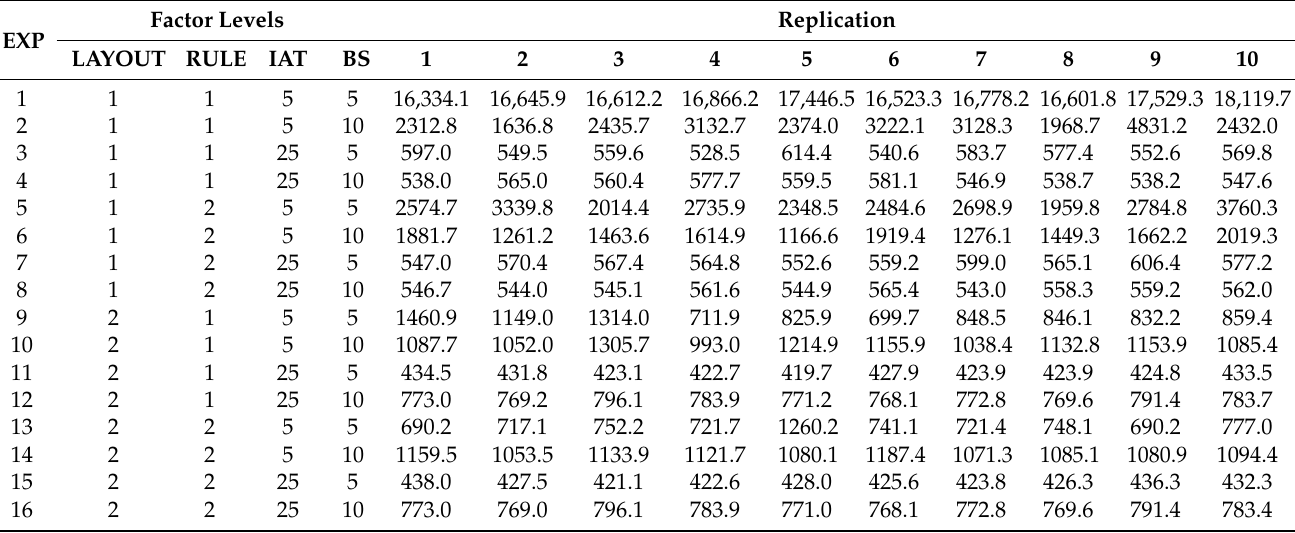
Table A1. MFT simulation results according to DoE.